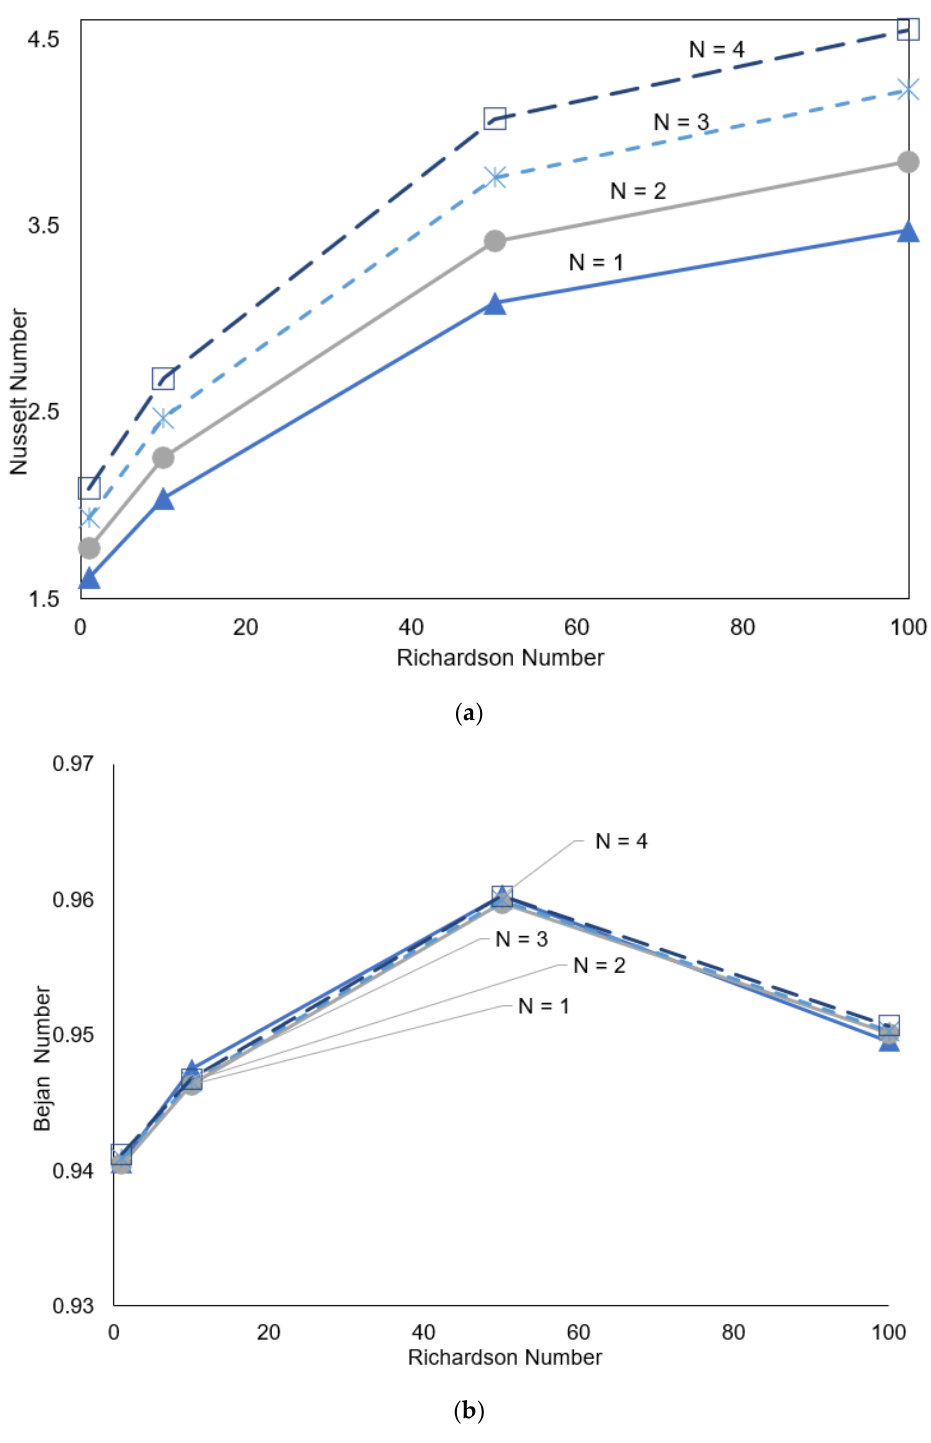
Figure 7. ( a ) Nusselt number, γ : 0°; N = 1, 2, 3, 4; Ha = 0; Ri = 1, 10, 50, 1; φ = 0.02. ( b ) Bejan number, γ : 0°; N = 1, 2, 3, 4; Ha = 0; Ri = 1; φ = 0.02.